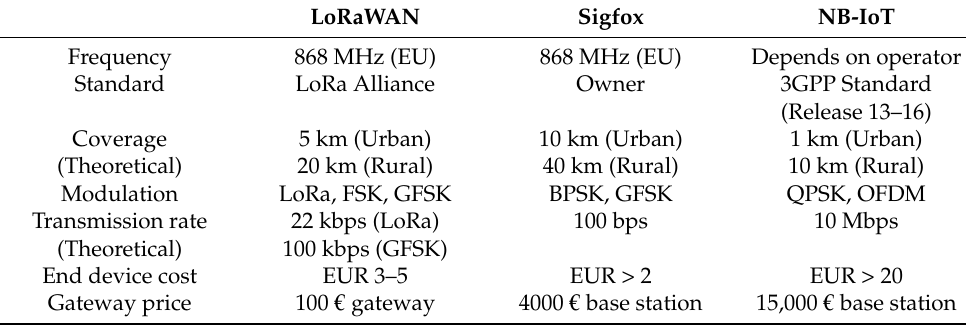
Table 1. A comparison of LPWAN technologies.